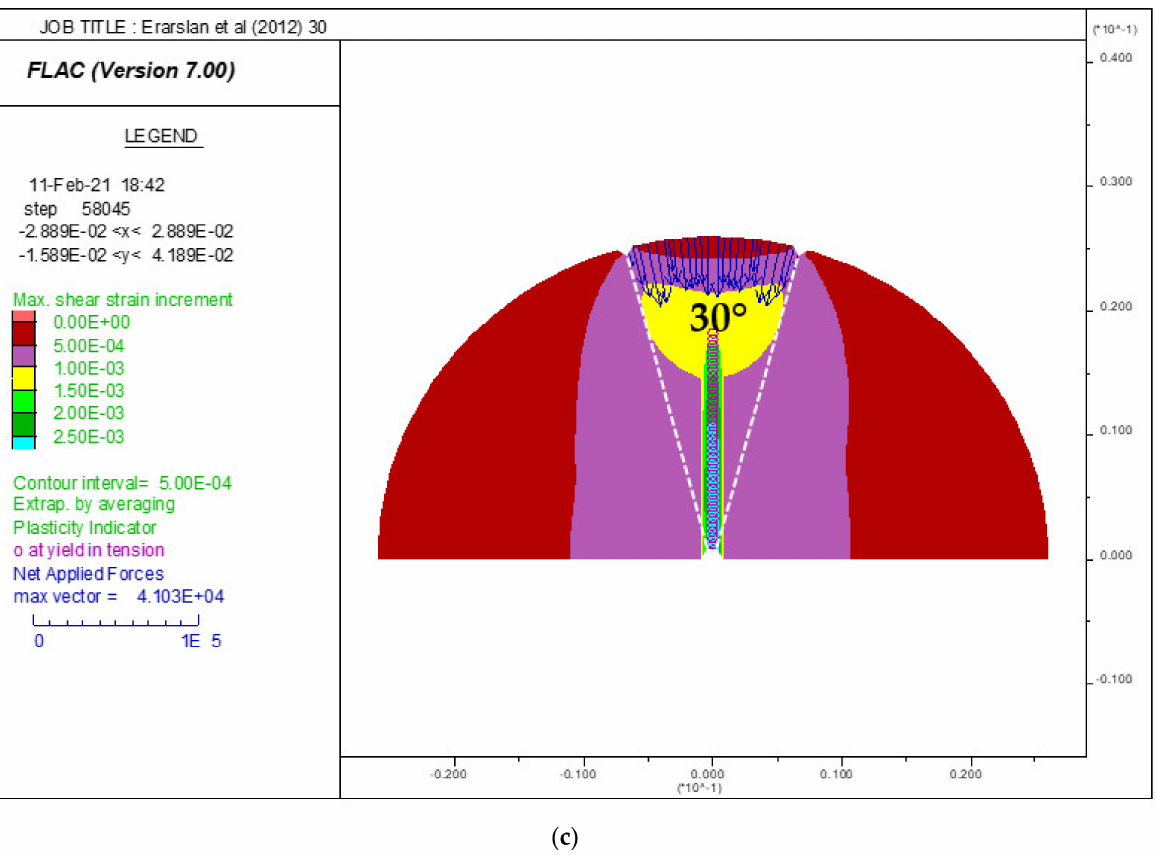
Figure 5. ( a ) Arch loading angle 2 α = 15 ◦ . ( b ) Arch loading angle 2 α = 20 ◦ ( c ) Arch loading angle 2 α = 30 ◦ . Numerical Distribution of maximum shear strains, crack initiation point positions, and applied pressure in the disk tested by [6].